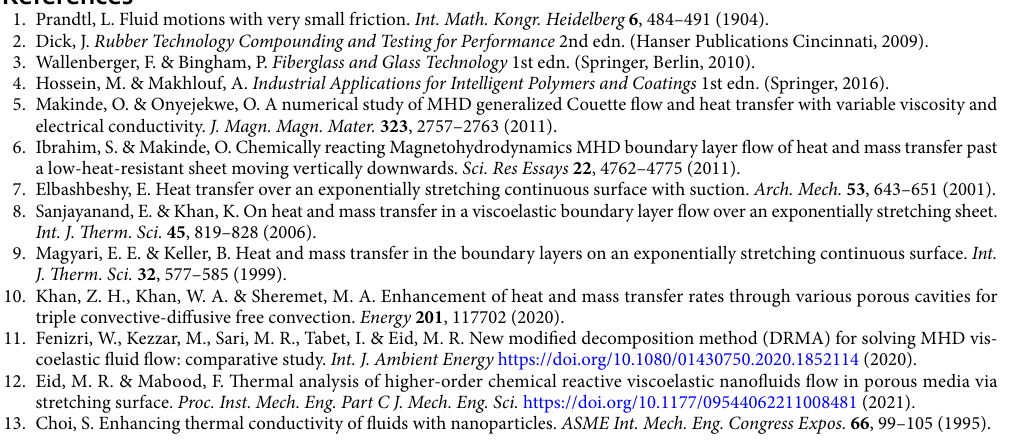
− 1 2 x for Pr = 7.38